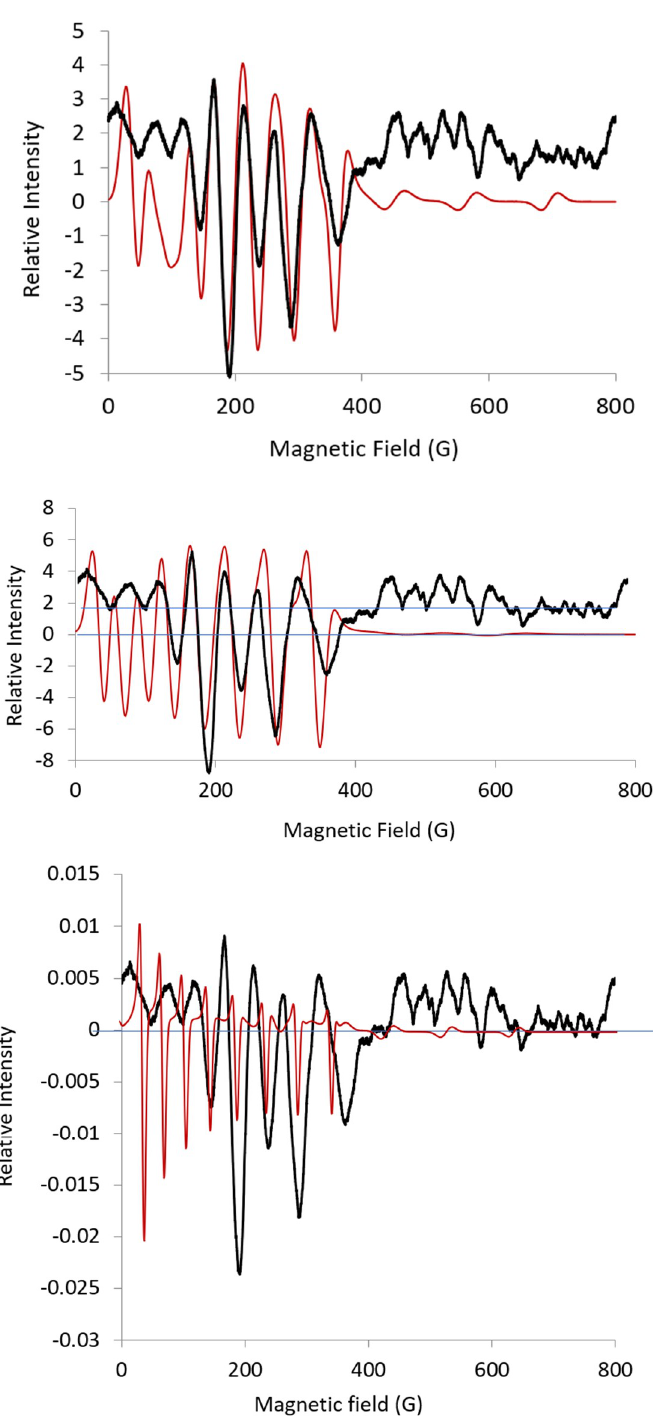
Figure 9. Second harmonic L-band spectrum (black) for CoEDTA as described in Figure 4. Simulation (red) using EPR parameters: g = [6.0, 5.0, 2.1], A = [200, 300, 162], HStrain = [500, 25, 50], bottom spectrum. Simulation (red) using EPR parameters: g = [5.0, 4.32, 2.10]; A = [244, 300, 162]; HStrain = [133, 140, 200]; middle spectrum spectrum; simulation (red) using EPR parameters g = [5.08, 4.14, 2.05]; A = [293, 221, 201]; HStrain = [174, 116, 81]; final simulation obtained running Monte Carlo option from EasySpin over a weekend with Vary.g = [0.2, 0.2, 0.2]; Vary.A = [50, 50, 50]; Vary.HStrain = [50, 50, 50]; center values: g = [5.0, 4.3, 2.0]; A = [300, 244, 162]; HStrain = [178, 123, 50].